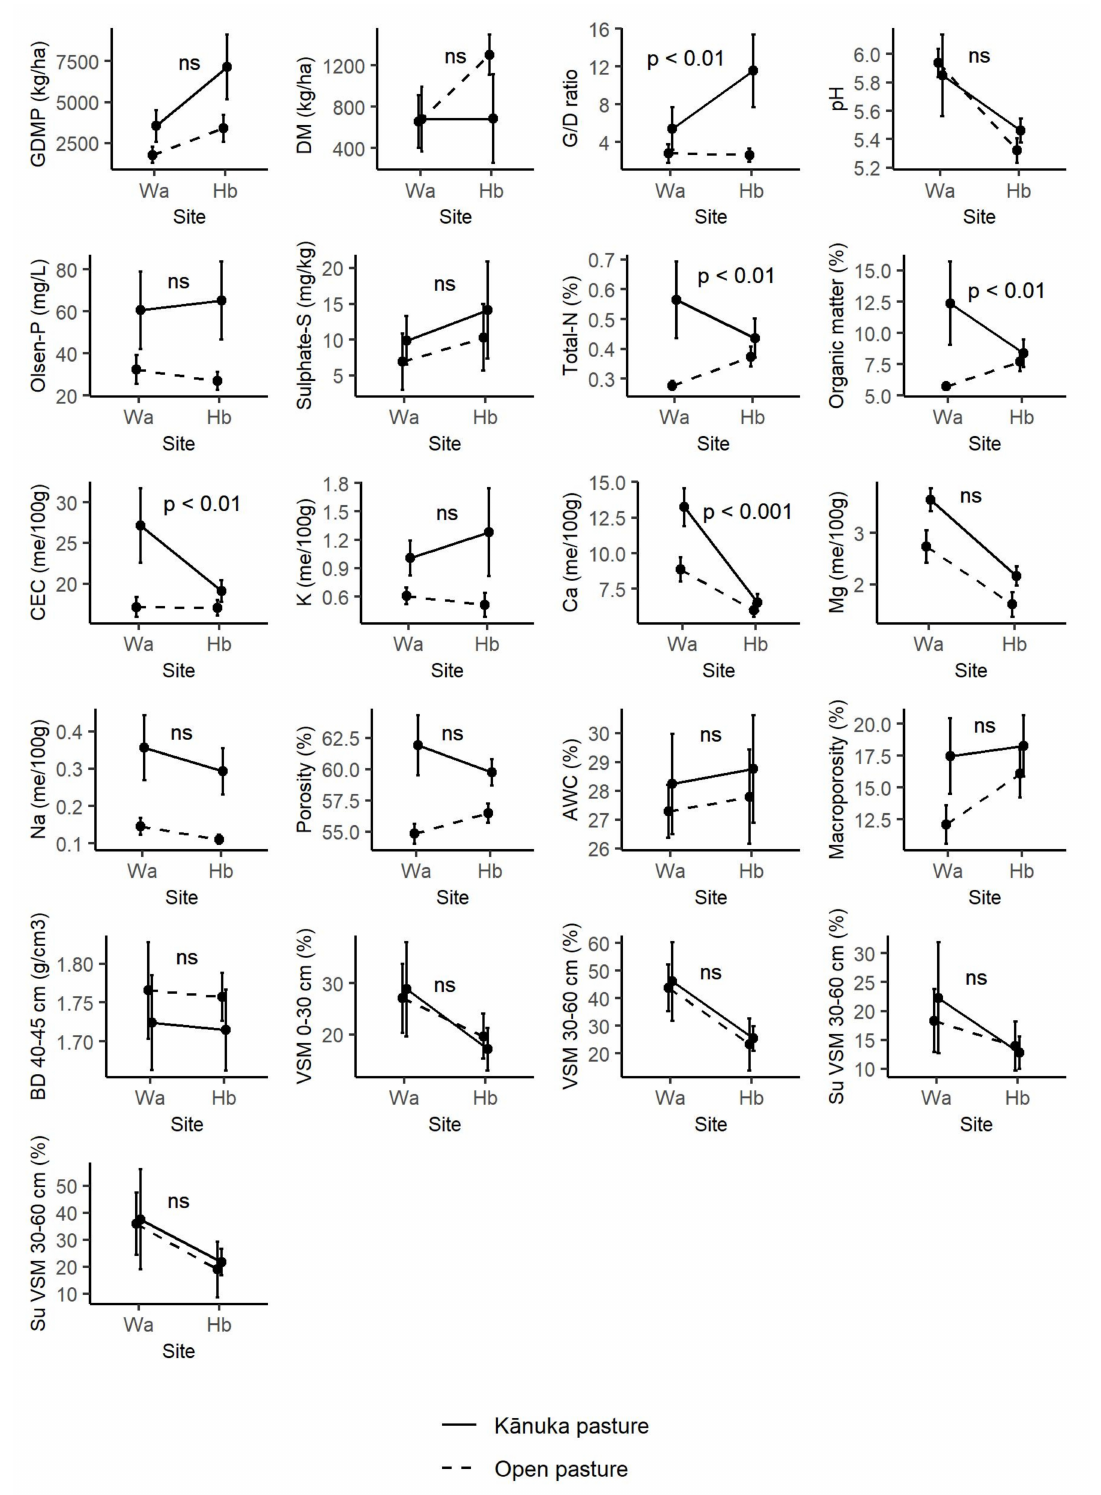
Figure 2. Pasture production and abiotic factor treatment and site interactions. The error bars are the 95% confidence intervals. ns = not significant. Wa = Wairarapa. Hb = Hawkes Bay. GDMP = green dry matter production. DM = dead matter. G/D = green:dead. P = phosphorus. S = sulphur. N = Nitrogen. CEC = cation exchange capacity. K = potassium. Ca = calcium. Mg = magnesium. Na = sodium. Porosity = porosity 2–5 cm. AWC = available water content 2–5 cm. Macroporosity = macroporosity 2–5 cm. BD = bulk density. VSM = volumetric soil moisture. Su =